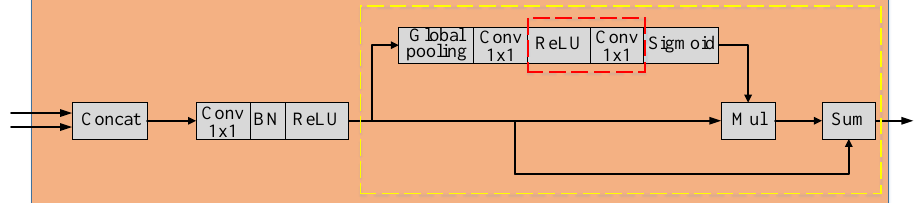
Figure 5. The fusion